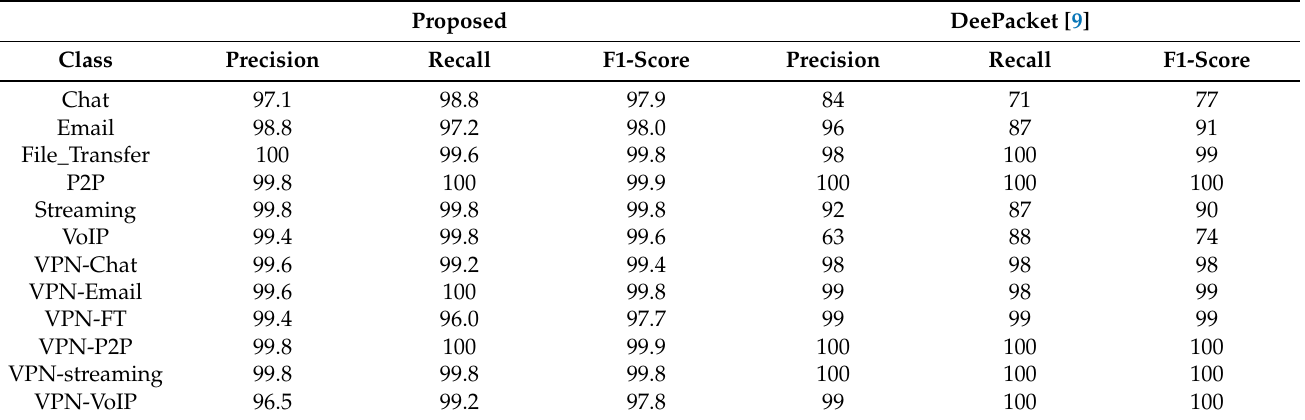
Table 8. Performance for each type of encrypted traffic service identification.